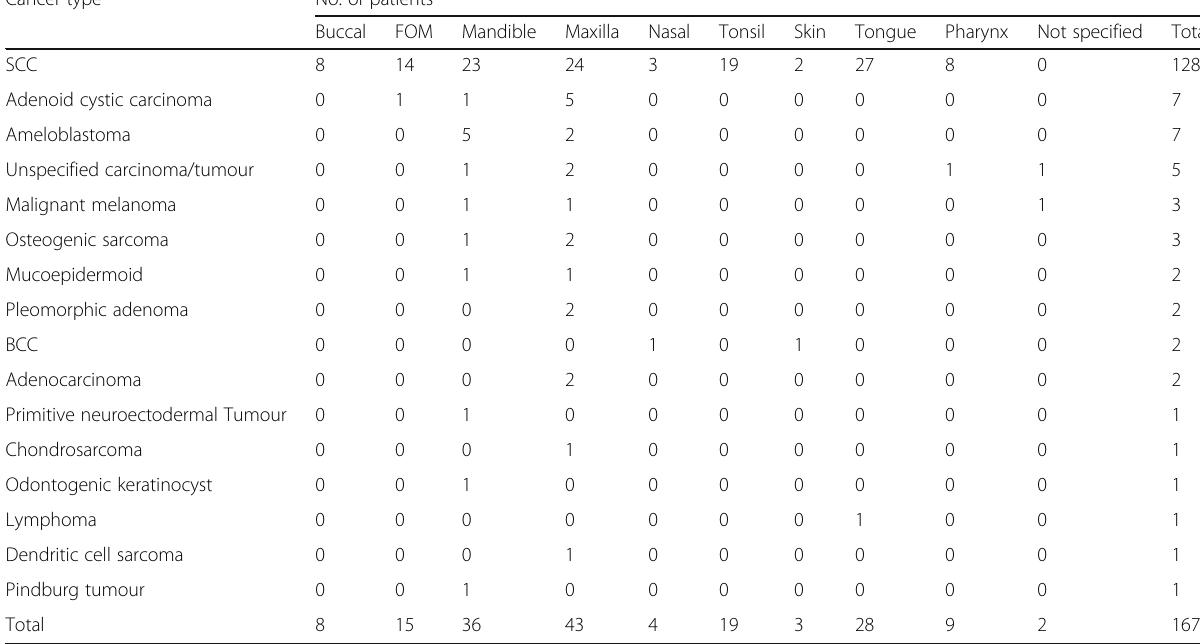
Table 1 Summary of cancer type and site of the study population Cancer type